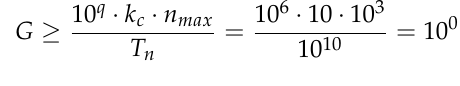
Figure 4. PPSG statistical characteristics based on MAFG ( q = 6 ) : ( a ) the value χ 2 c ; ( b ) the average value of the last five (current) values χ 2 c − χ 2 cav ; ( c ) number of values χ 2 cav greater than χ 2 cr . G—control code value.